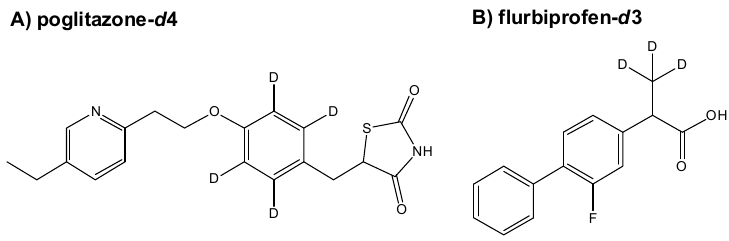
( A ) and flurbiporfen- d 4